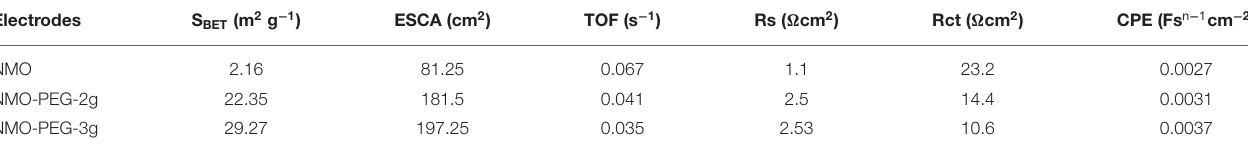
FIGURE 3 | (A) LSV curves of NMO, NMO-PEG-2g, and NMO-PEG-3g detected in 1M KOH at a sweep rate of 5mV s − 1 ; (B) Tafel plots for LSV curves of NMO, NMO-PEG-2g, and NMO-PEG-3g; (C) 1st, 1,000th, and 2,000th LSV curves at sweep rate of 50mV s − 1 ; (D) Stability test of NMO-PEG-3g catalyst at an over-potential of 112mV for 25h. TABLE 1 | Electrochemical parameters of the NiMnO as the HER catalyst in alkaline medium.